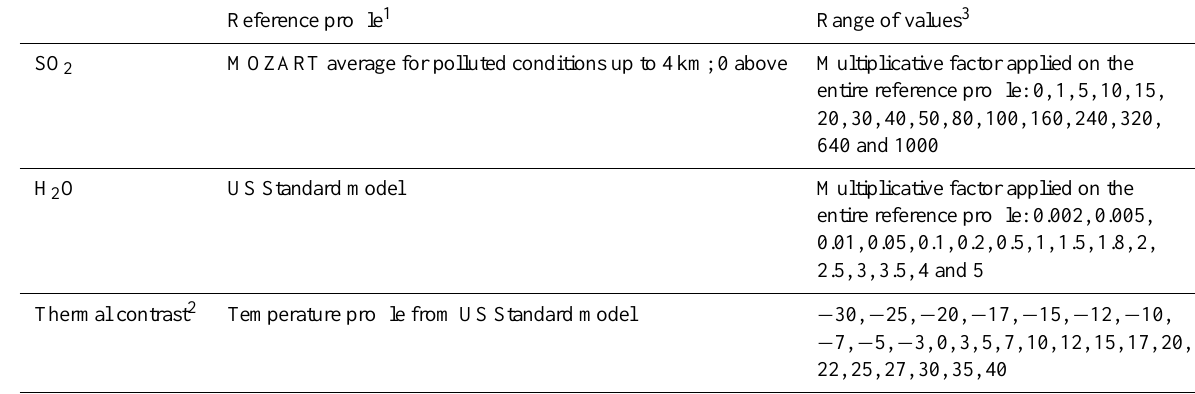
Table 1. Range of atmospheric situations considered for the forward model runs used as reference for the LUTs.